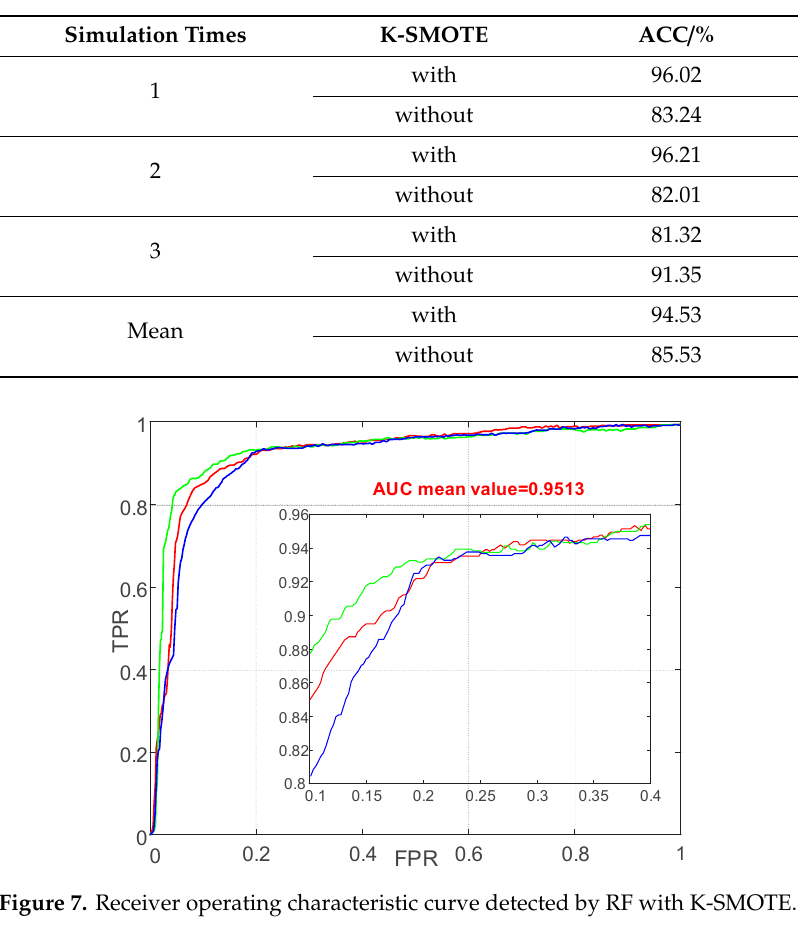
Table 4. Accuracy value of random forest.